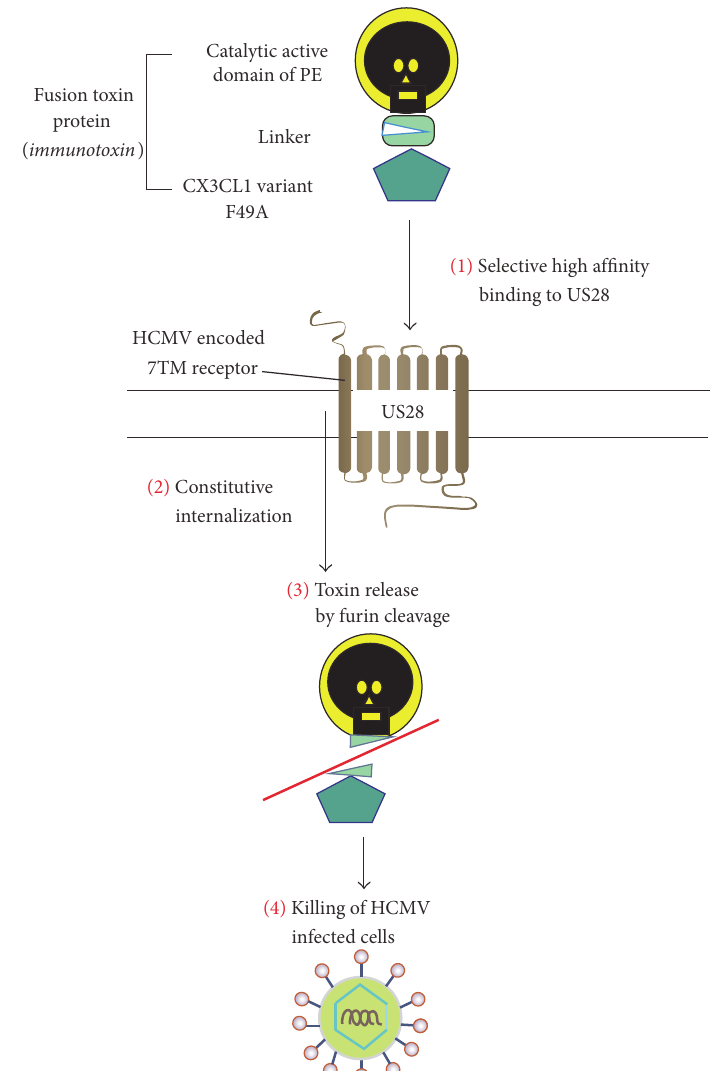
Figure 1: Selective killing of HCMV infected cells by F49A-FTP. The FTP consisting of the CX 3 CL1 variant F49A and the catalytic active domains of PE binds selectively to US28 (1), and the internalization of the FTP is triggered by internalization of F49A binding to US28 (2). The release of F49A is achieved by furin cleavage (3), and the protein synthesis is inhibited by PE, leading to (4) killing of the human cytomegalovirus (HCMV) infected